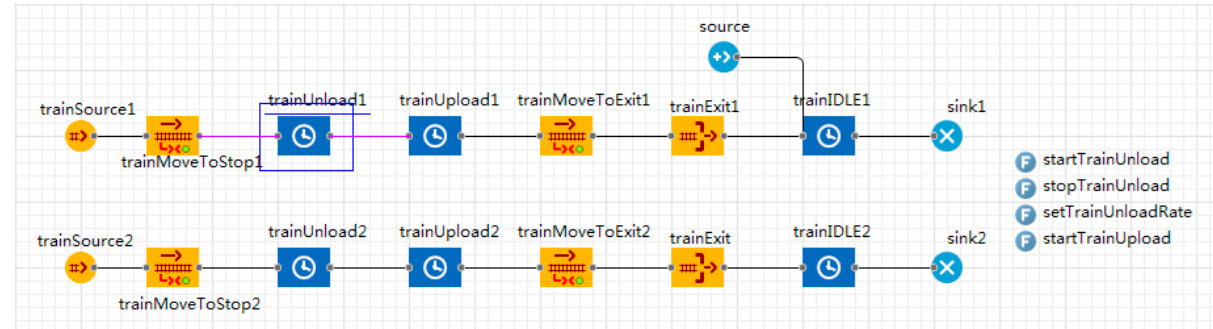
Figure 7. Train operation simulation modeling.